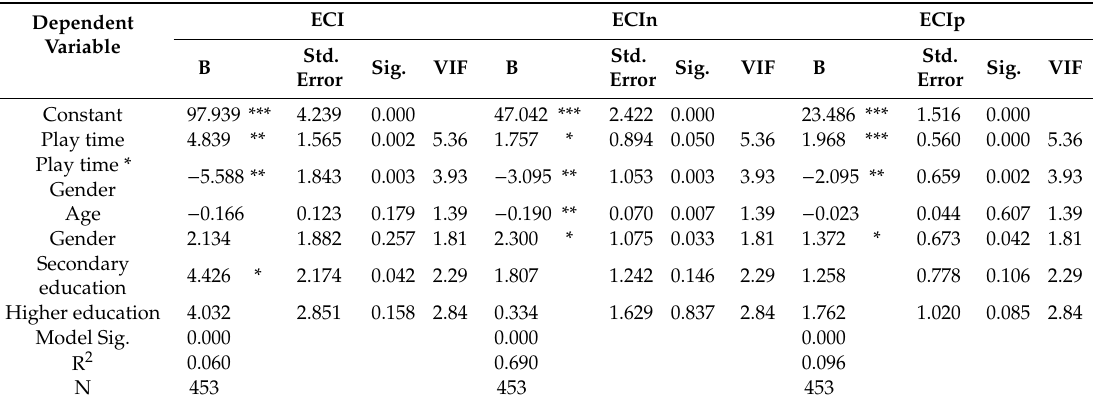
Table 3. The relationship between the emotional creativity inventory (ECI), its subscales novelty (ECIn) and preparedness (ECIp), and the frequency of playing computer games moderated for gender. Results of the multivariate regression analysis.